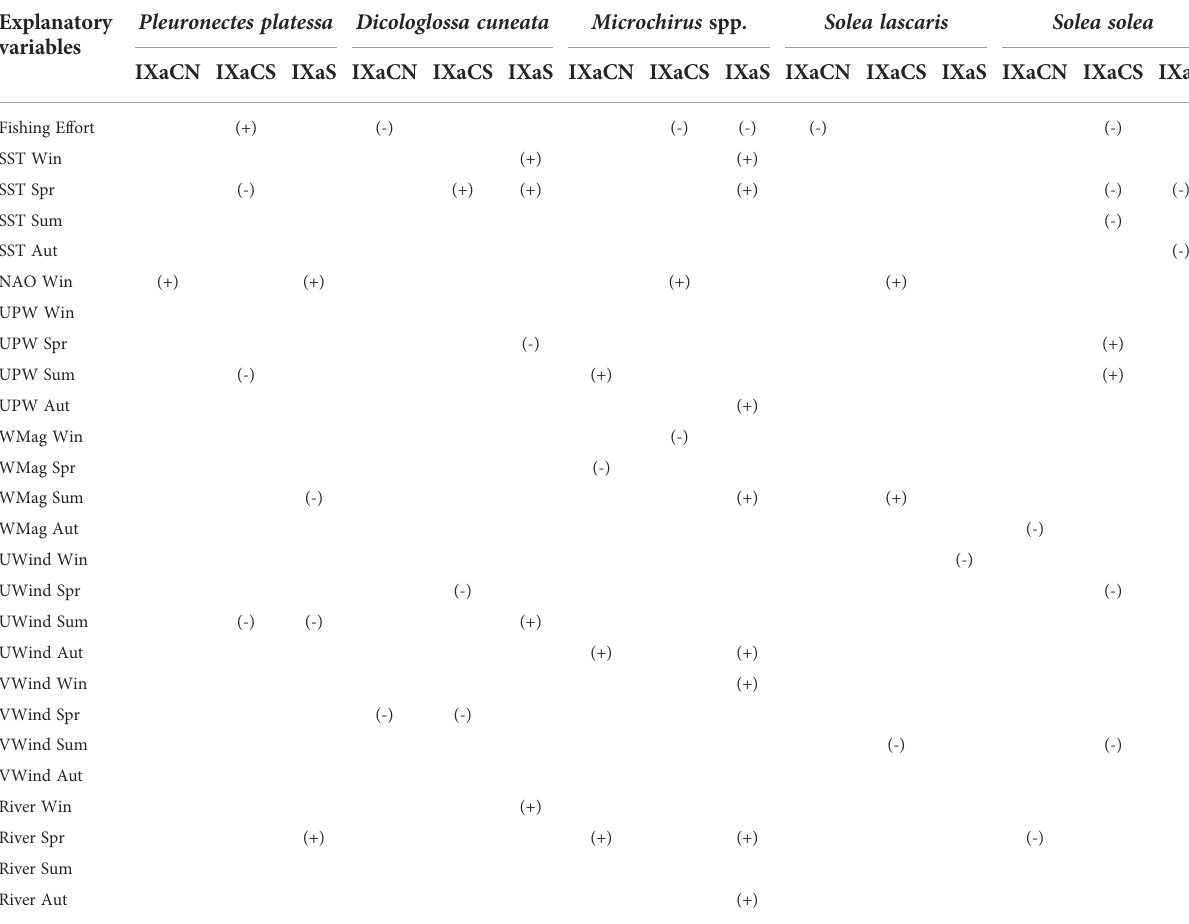
TABLE 3 Summary of results of relationships (signi fi cant in two or more time series analysis) between each fl at fi sh species (Landings per unit effort- LPUE) and explanatory variables ( fi shing effort and environmental factors) using Min/Max Autocorrelation Factor Analysis (MAFA), Dynamic Factor Analysis (DFA) and Generalised Least Squares (GLS) corresponding to the age-group 0 (Lag3 for Pleuronectes platessa , Microchirus spp., Solea lascaris and Solea solea , and Lag2 for Dicologlossa cuneata ), along the Portuguese coast: Northwest (IXaCN), Southwest (IXaCS) and South